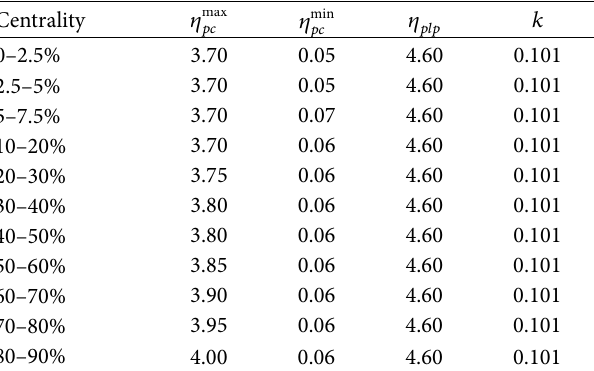
Figure 2: Pseudorapidity density of charged particles produced in Tev. The filled circles indicate the Xe–Xe collisions at √푠 𝑁𝑁 = 5.44 experimental data in 12 centrality bins [6]. The lines are the results of the Equations (7)–(10). Table 4: Values of parameters corresponding to the curves in Figure